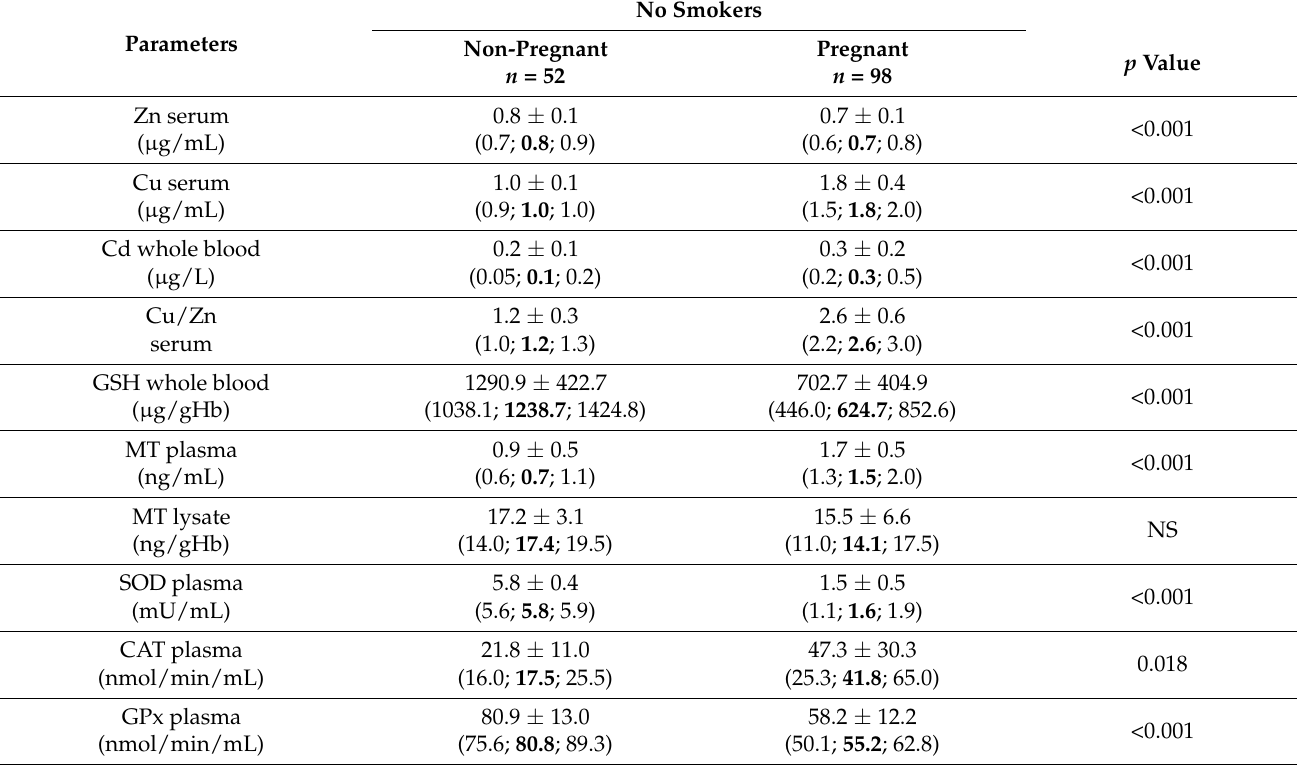
Table 2. Values of selected antioxidative parameters, and metals in nonsmokers.